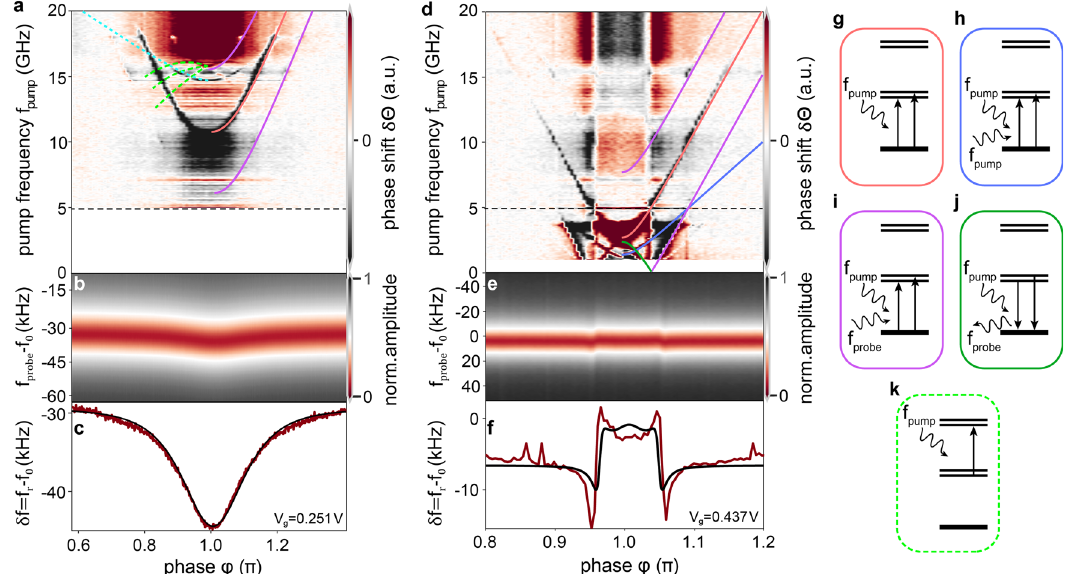
Fig. 6 Flux-dependent state dispersion for different gate voltages and schematic overview of the observed transitions. a Two-tone Andreev bound state spectrum at a gate voltage of V g = 0.251 V (blue dashed line in Fig. 4 a) as a function of the magnetic fi eld induced phase difference φ across the junction. The red line is a fi t to the pair transition driven by the pump tone using the short channel model with parameters τ = 0.96 ± 0.03, Δ = 105 ± 37 μ eV. The purple lines correspond to a corresponding two photon process caused by the absorption or emission of an additional resonator photon. The dashed blue line indicates another two-particle transistion feature from another set of Andreev states. Dashed green lines highlight a set of single-quasiparticle transitions between spin polarized Andreev levels. b Single-tone measurement of cavity response at the same V g as in ( a ). The resonance frequency is extracted and plotted in c alongside a fi t to a Jaynes-Cummings Hamiltonian (solid black line). Fit parameters are γ = 9.7 ± 0.1 GHz, Z = 1.09 ± 0.02 × 10 − 6 , f offset = − 29 kHz, g eff ( π ) = 78 ± 1 MHz, and κ = 0.1964 MHz. d Two-tone spectrum at a gate voltage of V g = 0.4374 V (red dashed line in Fig. 4a). Again a prominent two particle transition is observed and fi tted with a short channel model with τ = 0.998 ± 0.001, Δ = 132 ± 40 μ eV (solid red line). Two photon transitions (solid purple lines) which utilize both cavity and pump photons are also observed. Additionally, a solid blue line indicates a two photon pair transition using two pump photons. The solid green line corresponds to a higher-order transition due to the combination of a pump- induced single resonator photon and the relaxation of an Andreev level. e Single-tone measurement of cavity response at the same V g as in ( d ). The resonance frequency is extracted and plotted in f alongside a fi t to a Jaynes – Cummings Hamiltonian (solid black line). Fit parameters are γ = 0.9 ± 0.2 GHz, Z = 4.8 ± 0.7 × 10 − 8 , f offset = − 8.4 kHz, g eff ( π ) = 22 ± 3 MHz, and κ = 0.1964MHz. g – k Schematics of the different transitions being discussed in a and d showing quasi-particle excitations from Andreev levels (two parallel lines) or the ground state (solid line) and the pump or probe photons that contribute to the